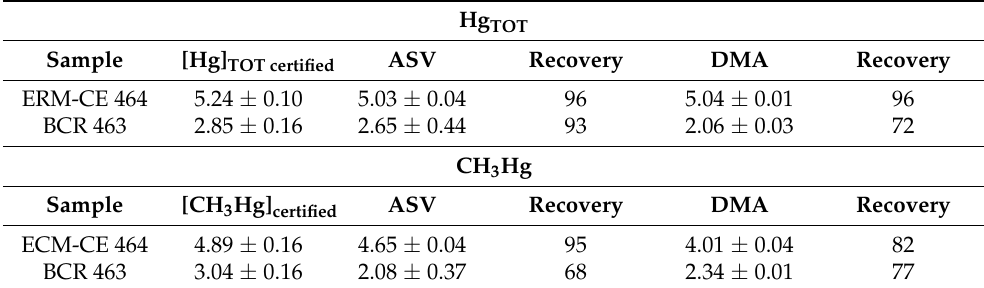
Table 1. Concentrations (mg kg − 1 ) and recoveries (%) obtained for Hg TOT and CH 3 Hg for the analysis of certified materials (tuna fish).